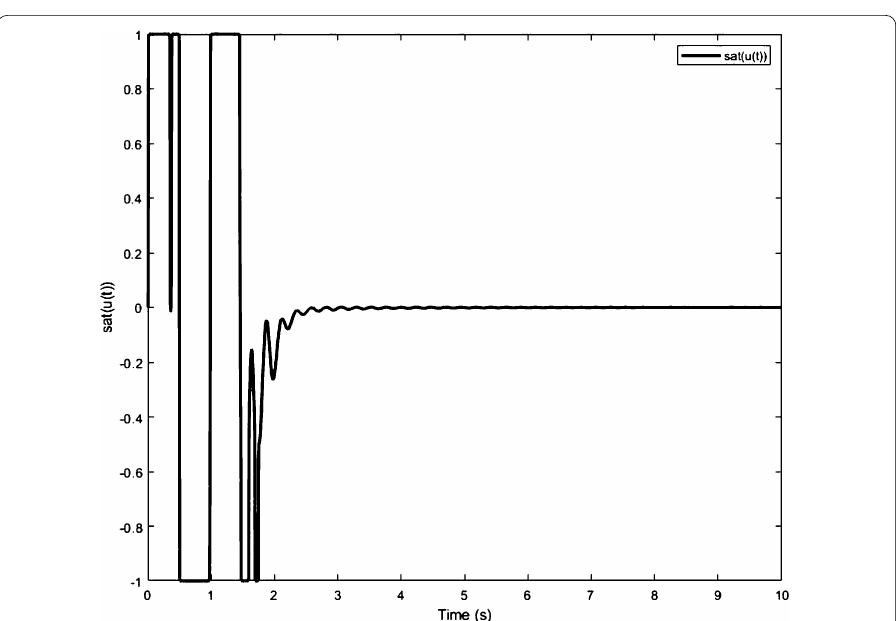
Figure 8 Time history of the saturated control input applied for the FHPS